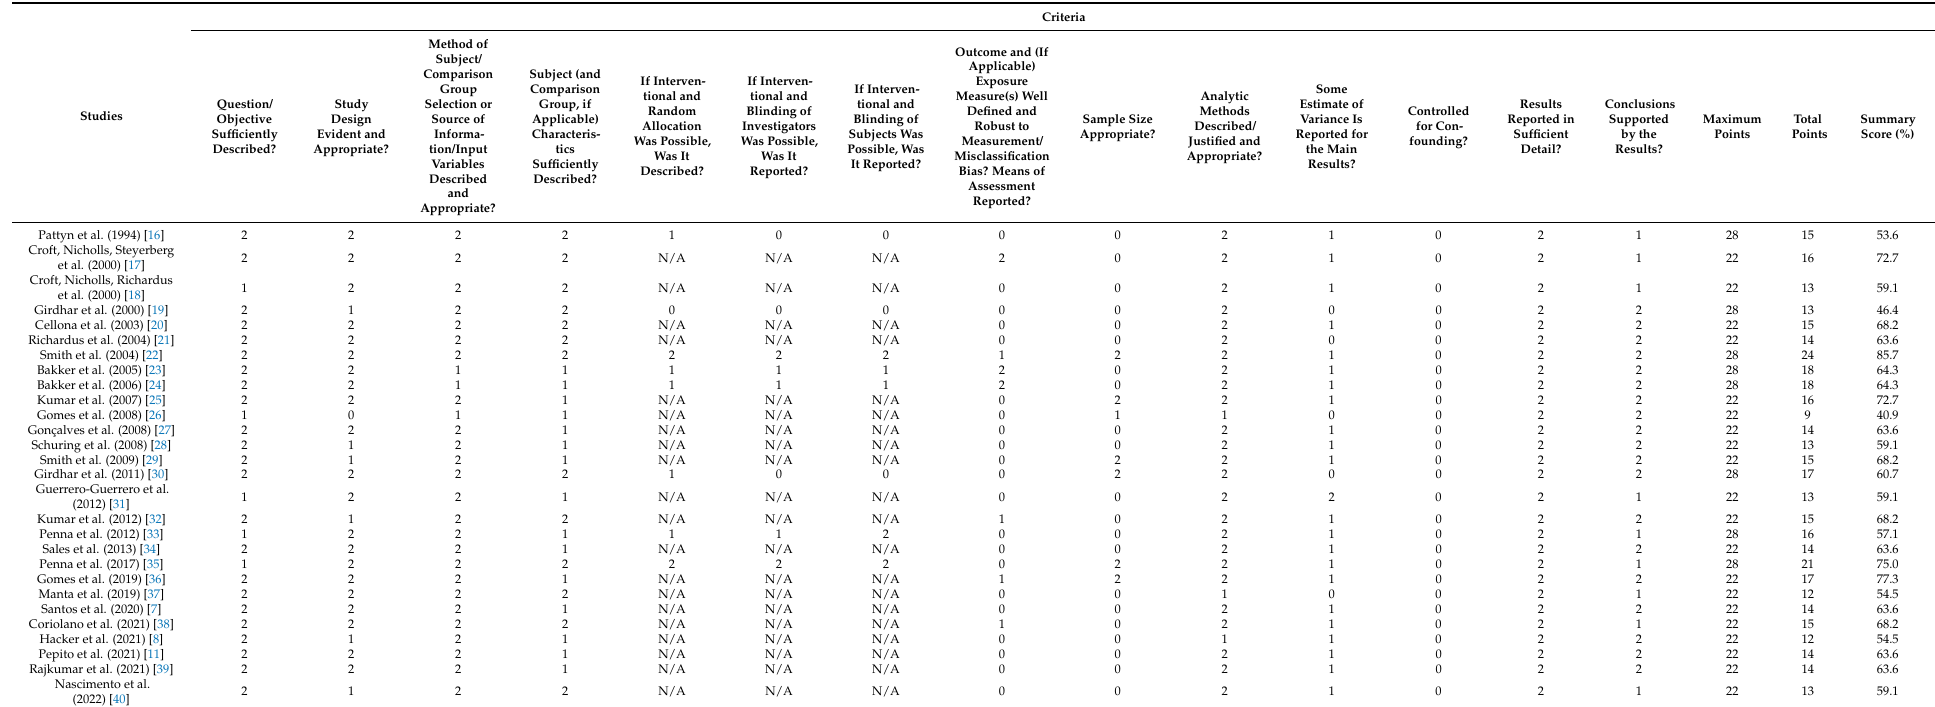
Table 7. Quality evaluation of the included